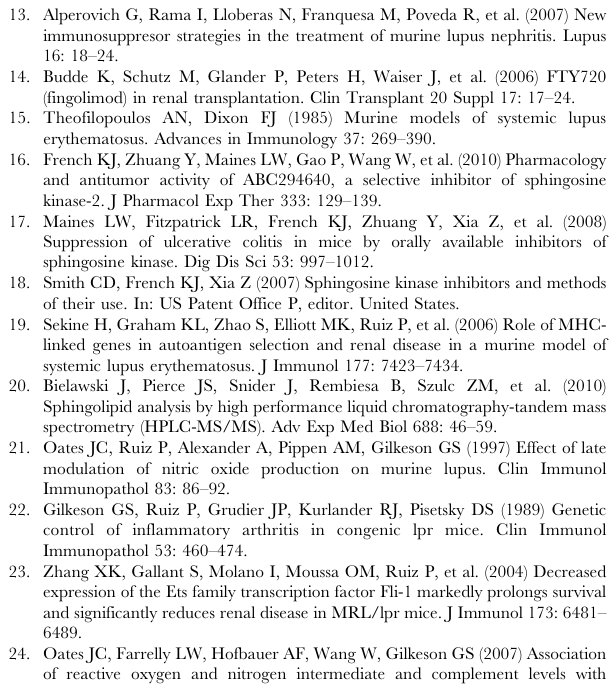
Table S3 Urine albumin measurements. Urine samples were collected from mice every two weeks of the study, beginning at week 0. Values are mean 6 SD. { Significantly different from lpr + vehicle, p , 0.05; *Significantly different from MpJ + vehicle, p , 0.05; **Significantly different from MpJ + vehicle p , 0.01 by One-way ANOVA; n $ 10. Table S4 Kidney Sphingolipid Measurements. Sphingo- lipid levels were analyzed by ESI/MS/MS from kidney homog- enate following 10 weeks of either treatment with vehicle or ABC294640. Values are mean 6 SD. *Significantly different from MpJ + vehicle, p , 0.05; **Significantly different from MpJ + vehicle; p , 0.01, ***Significantly different from MpJ + vehicle, p , 0.001 by One-way ANOVA; n $